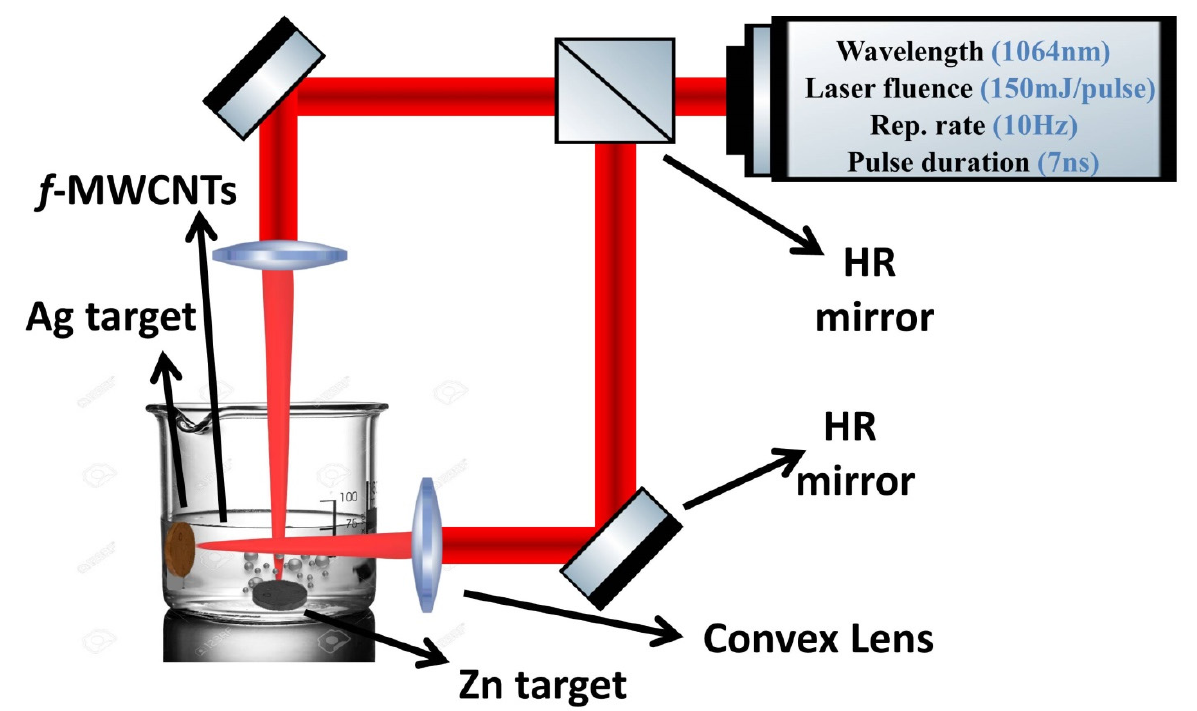
Figure 1. Schematic structure of preparation of Ag-doped ZnO/MWCNTs nanocomposite.